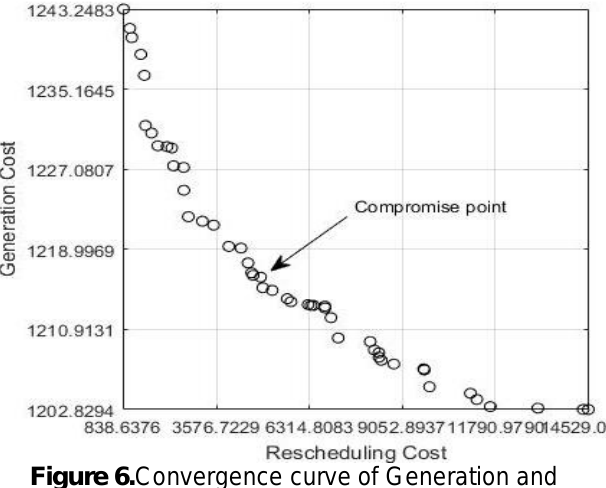
Figure 6. Convergence curve of Generation and Rescheduling Cost by MOPSO (Case